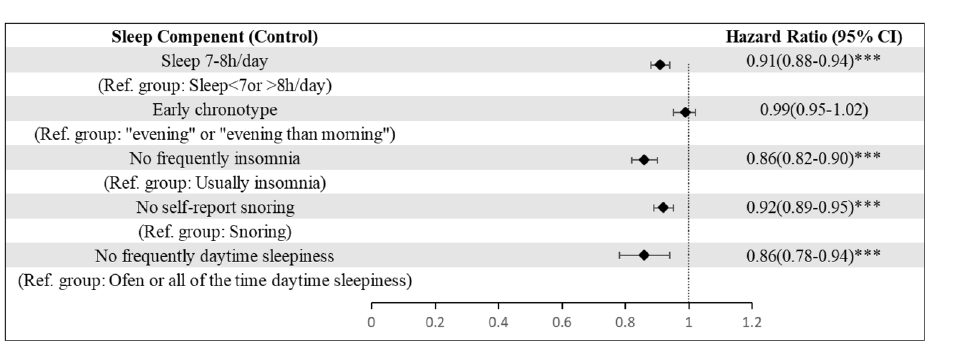
Figure 1. Hazard ratios (95% CI) of CRC events according to individual sleep components. 392,252 participants included in the model; hazard ratios (95% CI) were adjusted for age, sex, education, household income, family history of CRC, healthy lifestyle score.*, **, *** mean P-value < 0.05, 0.01, 0.001 respectively (the same